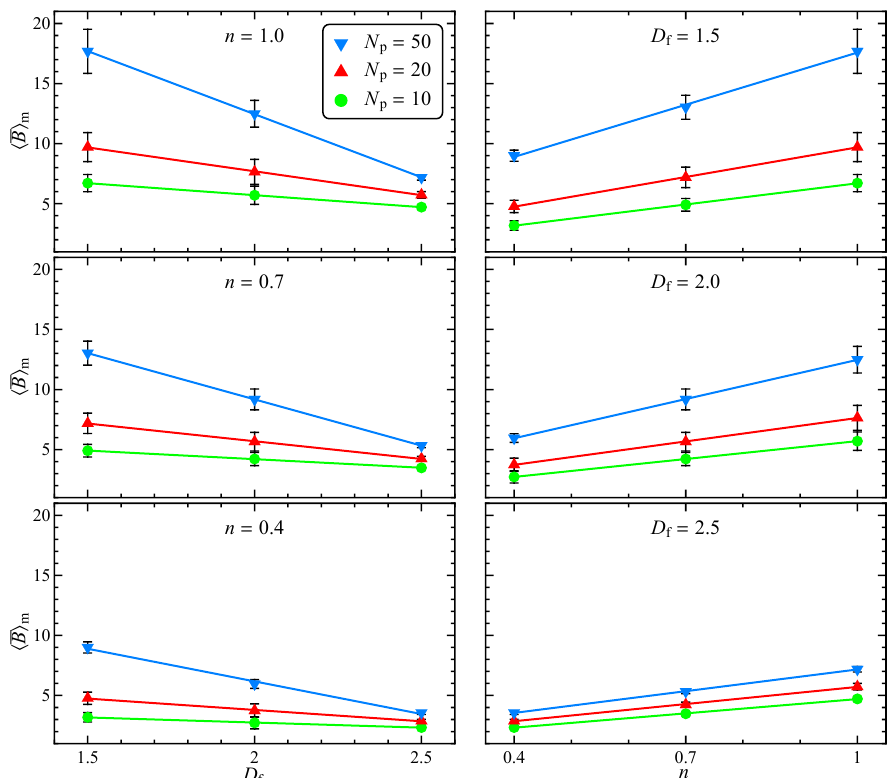
Figure 8. Ensemble-average intrinsic viscosity as a function of fractal dimension, parametric in the number of aggregate primary particles and for different flow indexes (left). Same data as a function of flow index for different fractal dimensions (right). The data standard deviation and trend line are also